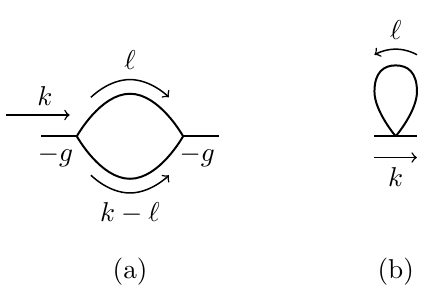
Figure 1 . (a) One-loop contribution to the 1PI two-point function. (b) A diagram where the loop consists of a single propagator closing on